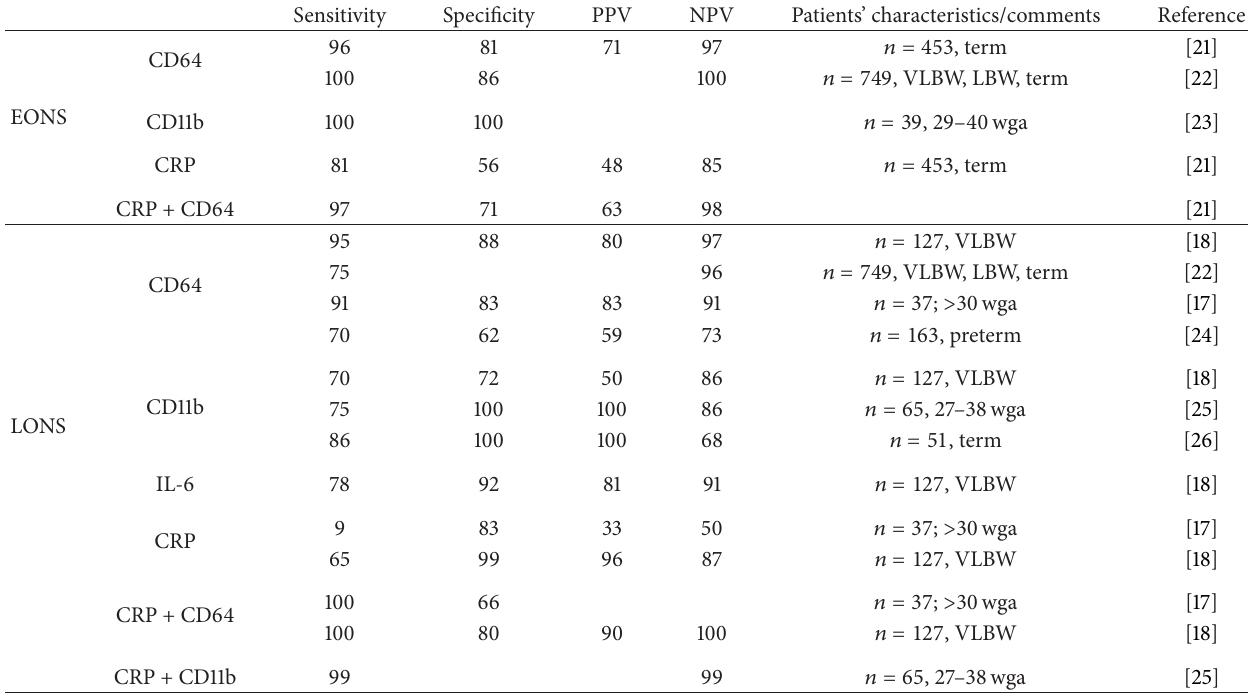
Table 1: EONS: early-onset neonatal sepsis; LONS: late-onset neonatal sepsis; VLBW: very low birth weight neonates; PPV: positive predictive value; NPV: negative predictive value; wga: weeks of gestational